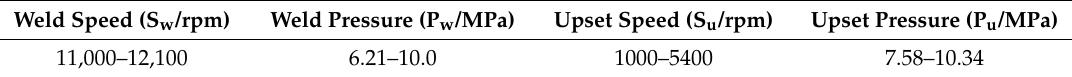
Table 5. Inertia friction welding processing parameters